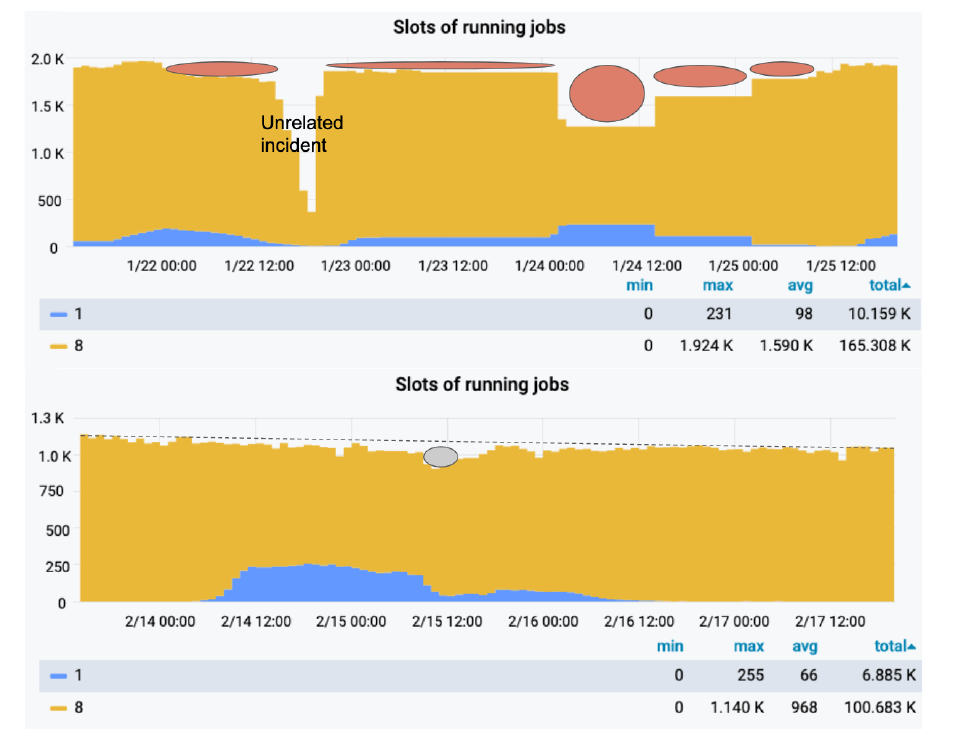
Fig. 3. CPU usage on the CERN Kubernetes cluster with the default scheduling algorithm (top) vs the node-packing policy (bottom). Resources that are unused due to inefficient scheduling are indicated with red ellipses. Also note the cluster size decreased from 2000 cores to 1000 cores, due to issues with the csi-cvmfs driver and the infrastructure at CERN, which were addressed at the